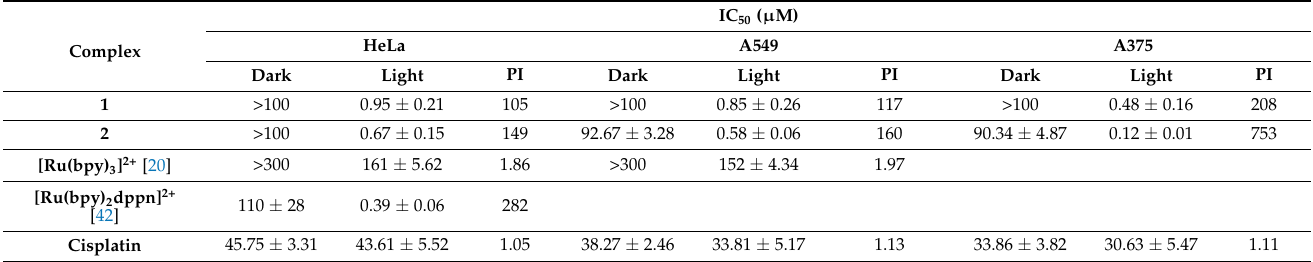
Table 1. The IC 50 and PI values for two complexes against tumor